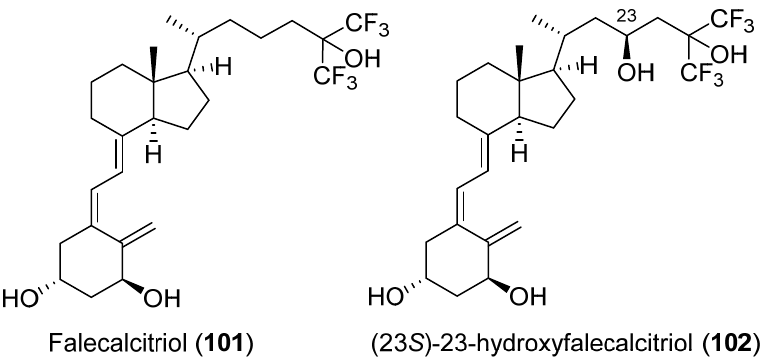
Figure 1. Structures of falecalcitriol ( 101 ) and its major metabolite (23 S )-23-hydroxyfalecalcitriol ( 102 ). The first synthesis of 26,26,26,27,27,27-hexafluoro-25(OH)D 3 ( 103 ) was reported by Kobayashi et al. in 1980 [76], and the same group subsequently synthesized 26,26,26,27,27,27- hexafluoro-1 α ,25(OH) 2 D 3 ( 101 ) in 1982 [77]. In this case, 3 β -Tetrahydropyranyloxychol-5-en- 24-ol tosylate was used as a starting material, and hexafluoroacetone (HFA) was utilized for construction of the 26,26,26,27,27,27-hexafluoro unit (Scheme 35). The biological evaluation revealed that 101 was approximately 5-10-fold more active than 1 α ,25(OH) 2 D 3 ( 1 ) without inducing severe hypercalcemia.